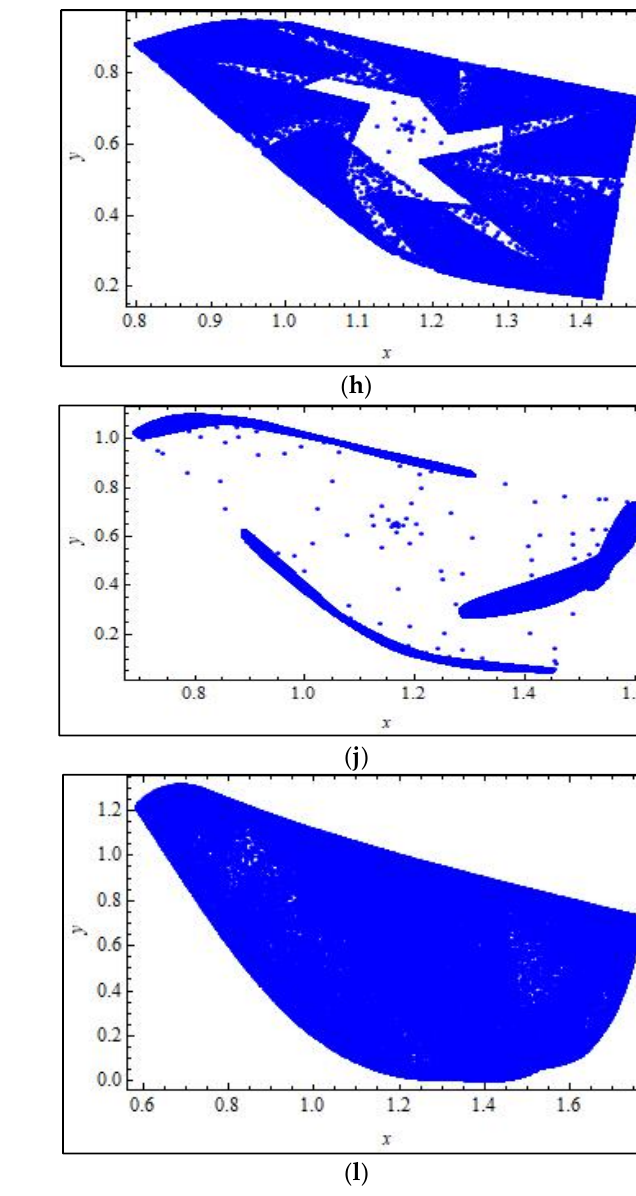
Figure 1. (a) s = 1.34 , (b) s = 1.3811, (c) (cid:1871) = 1.3874082082631611 , 1(d) s = 1.43 , (e) s = 1.607 , (f) s = 1.625 , Figure 1. ( a ) s = 1.34, ( b ) s = 1.3811, ( c ) s = 1.3874082082631611, ( d ) s = 1.43, ( e ) s = 1.607, (g) s = 1.66, (h) s = 1.68 , (i) s = 1.735 , 1 (j) s = 1.83 , (k) s = 1.89 , (l) s = 1.99. ( a )–( l ) Phase portraits of system (4) for different values of (cid:1871) ∈ [1,2] with (cid:1854) = 1.7, (cid:1853) = 2.26, (cid:1870) = 2.4, ℎ = 1.8, and (cid:1863) = 1.4 under the initial conditions (cid:1876) (cid:2868) = 1.0219, (cid:1877) (cid:2868) = 0.567721. b = 1.7, a = 2.26, r = 2.4, h = 1.8,and k = 1.4 under the initial conditions x 0 = 1.0219, y 0 =